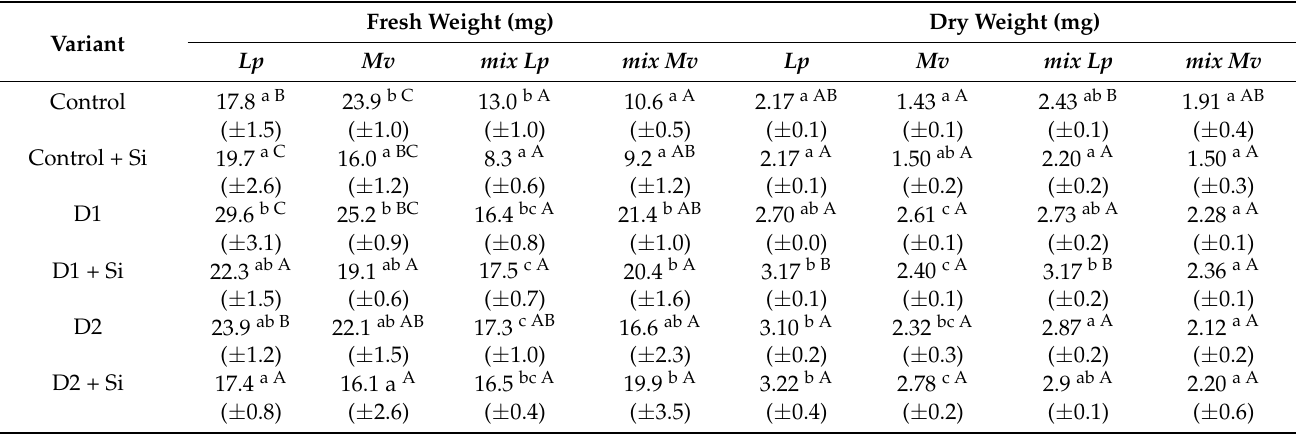
Table 5. Effects of different variants of drought conditions on fresh and dry weight of Lolium perenne ( Lp ) and Medicago x varia ( Mv )